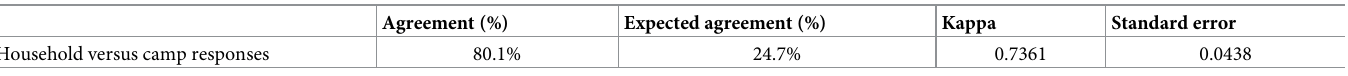
Table 2. Household and camp inter-rater reliability.